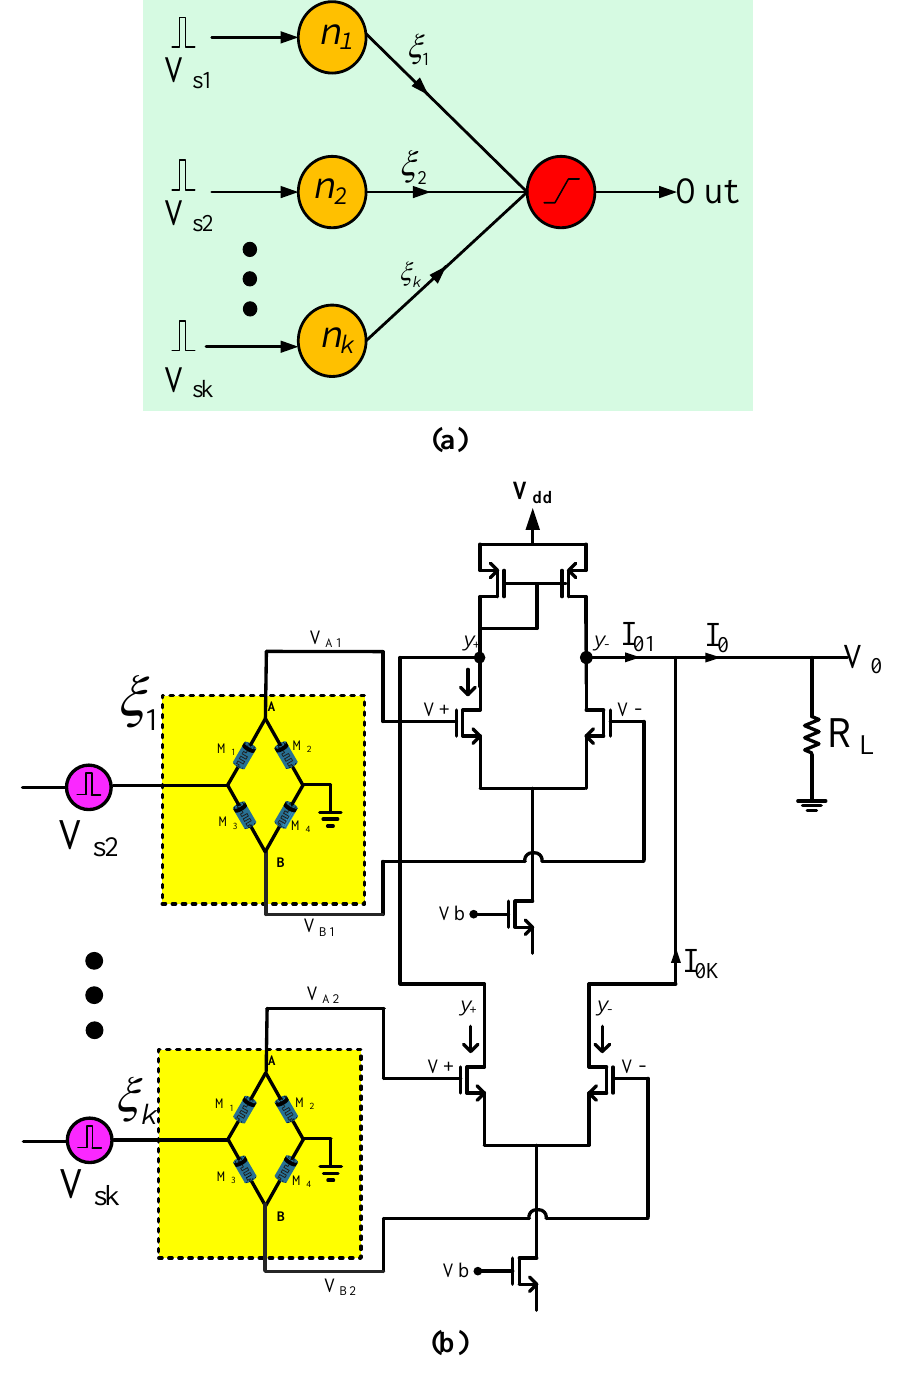
Figure 8. Neural circuit ( a ) Block diagram of single layer neural network ( b ) Memristor synapse-based neural